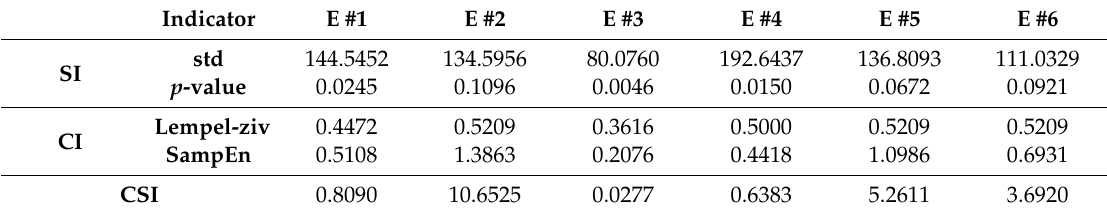
Table 1. Comprehensive selection indicator before dynamic time warping (DTW).